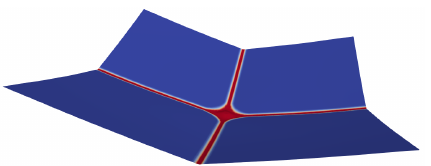
Figure 7. Visualisation of plate deflection.